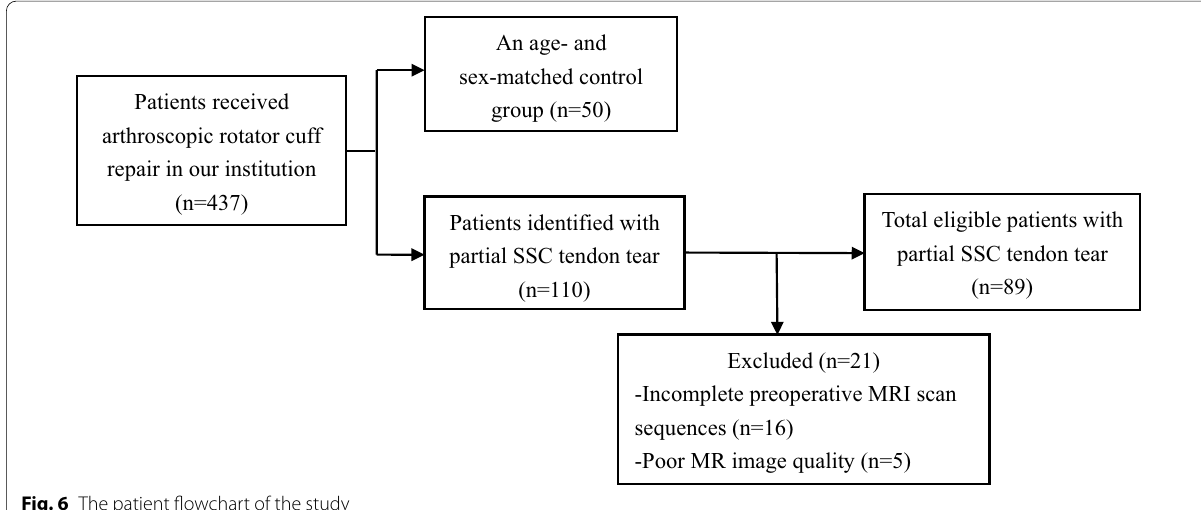
Fig. 6 The patient flowchart of the study